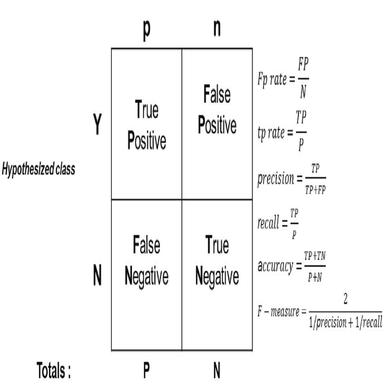
Confusion matrix and common performance metric.